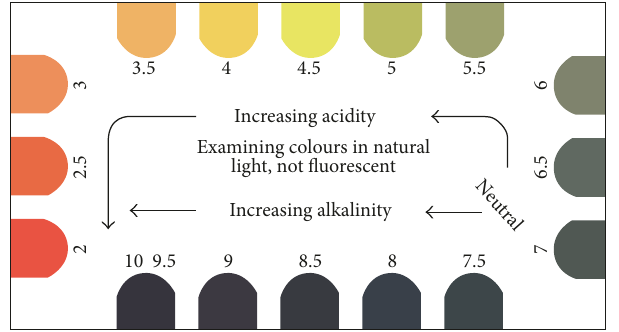
Figure 2: Example soil pH colour indicator card (Inoculo Labora- tories, Australia, 2014).